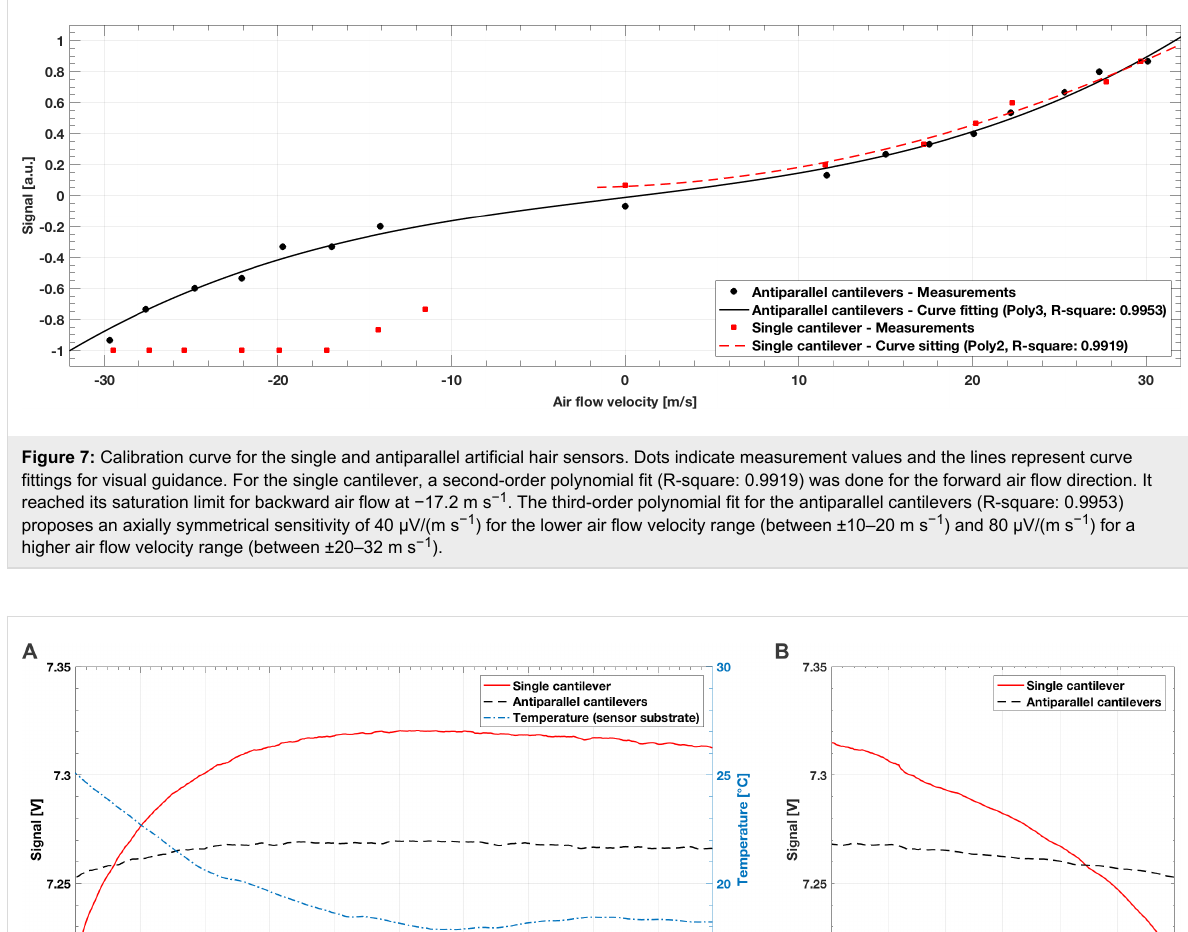
0.15 mV. The artificial hair sensors did not generate heat, which suggests that they changed their temperature with the environ- ment